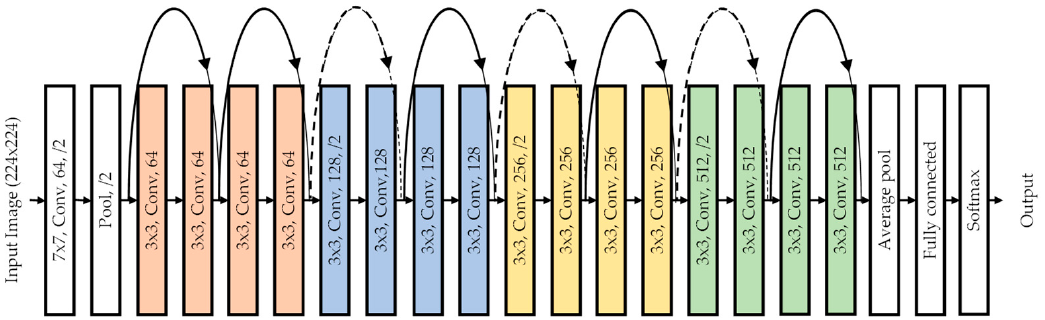
Figure 5. Structure of the Resnet-18 Model.